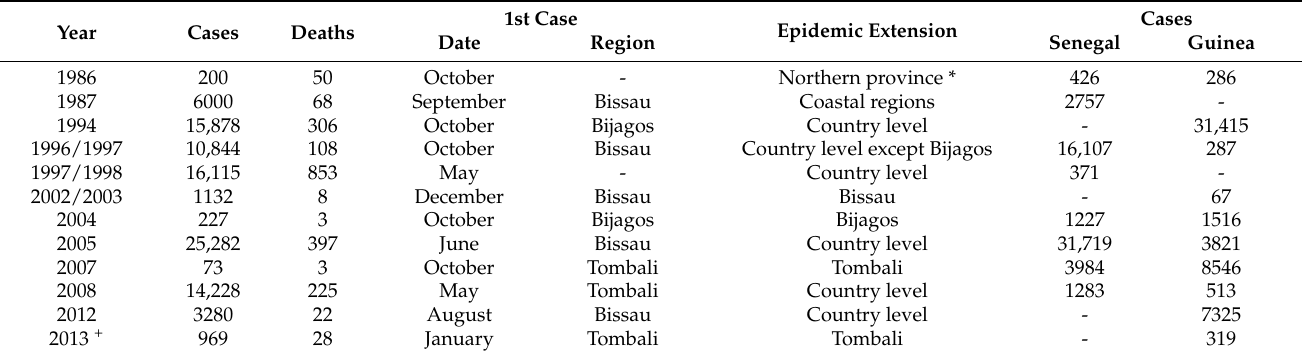
Figure 2. Geographical distribution of cholera cumulative incidence per 10,000 inhabitants by sector level in Guinea Bissau, 1986 − 2013. Source: Cholera Platform. (http://www.plateformecholera.info/attachments/article/231/GNB_incidence%20map_PhatChol.pdf, accessed on 7 September 2020). Table 1. Epidemiological parameters of cholera outbreaks in Guinea-Bissau between 1986 and